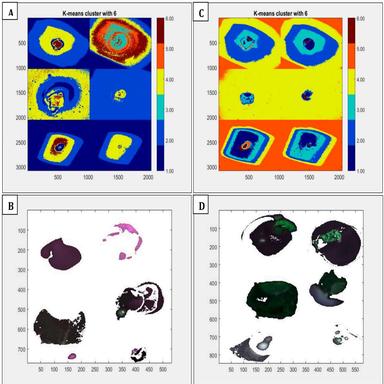
K-means clustering applied to select ROI background of NMI in ambient temperature and after melting process. A-B, NMI at RT, C–D, NMI after melting process. The ROI was selected, and pixels outside ROI were removed to reduce data complexity. This resulted in new X-PEEM data dimensions: B (532 × 770 × 72) and D (582 × 846 × 72).